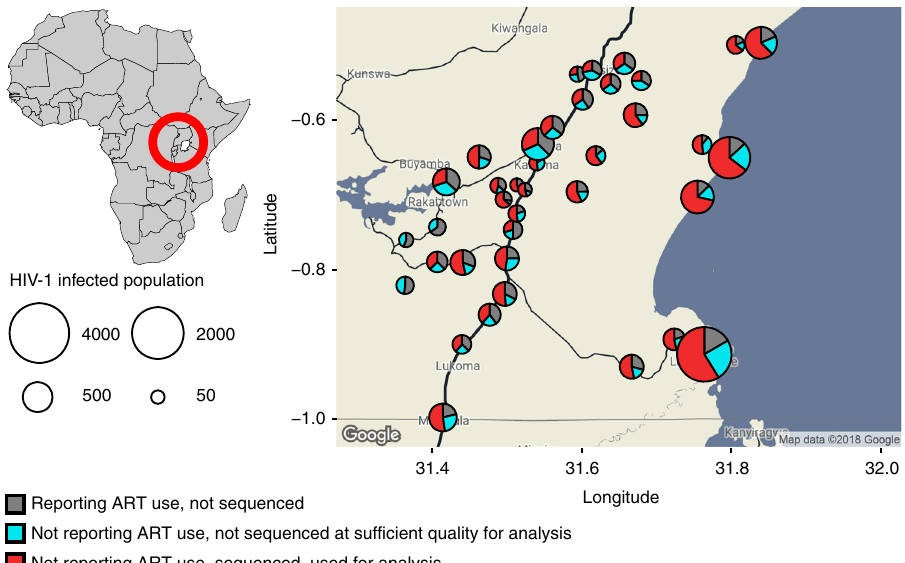
Fig. 2 HIV-1 deep-sequencing in the Rakai Community Cohort, Uganda. Individuals aged 15 – 49 years were surveyed from August 2011 to January 2015 in 40 communities. In all, 5142 men and women were found positive (circles). Of those, 1264 self-reported using antiretrovirals (grey area of circles), and were not considered further as sequencing is challenging when virus is suppressed by treatment. Samples from 3878 individuals were deep-sequenced (see Methods). Of those, samples from 1226 (31.6%) individuals were not of suf fi cient quality for analysis (blue area of circles). Speci fi cally, for phylogeny reconstruction, only paired-end merged reads of at least 250 base pairs (bp) in length were used, and subsequent deep-sequence inferences were performed on individuals whose reads covered the HIV-1 genome at a depth of at least 30 reads for 750 bp or more. Thus, samples from 2652 individuals (red area of circles) were used for molecular epidemiological analyses, corresponding to an estimated 45.1% of eligible and infected individuals